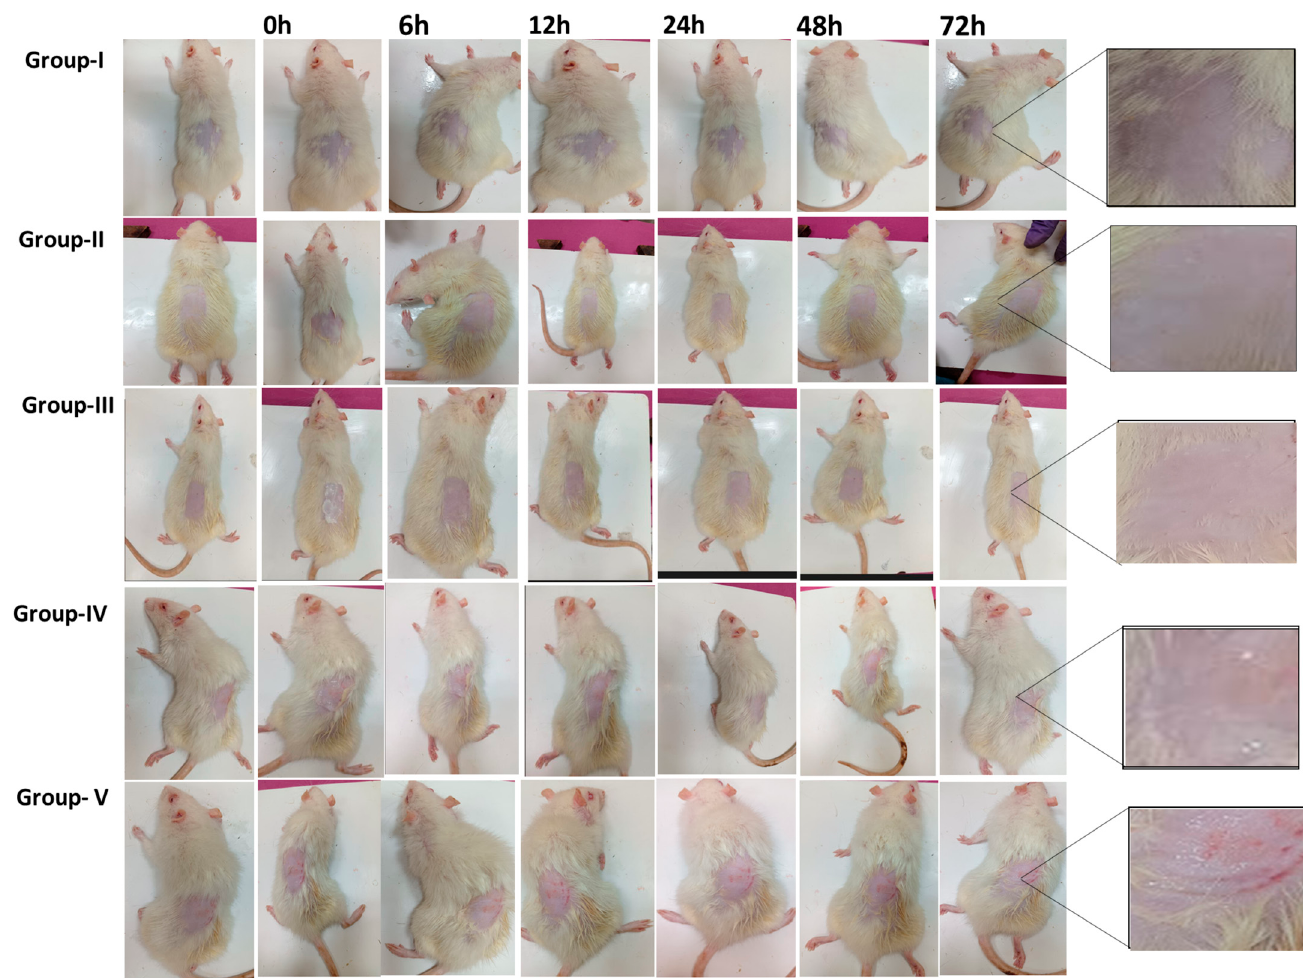
Figure 11. In vivo skin irritation study of Group I—untreated group; Group II—FDG (200 mg from 0.05% gel); Group III—CF018 emulgel (200 mg from 0.05% gel); Group IV—CF018P emulgel (200 mg from 0.05% gel); Group V—received 5% SLS gel.